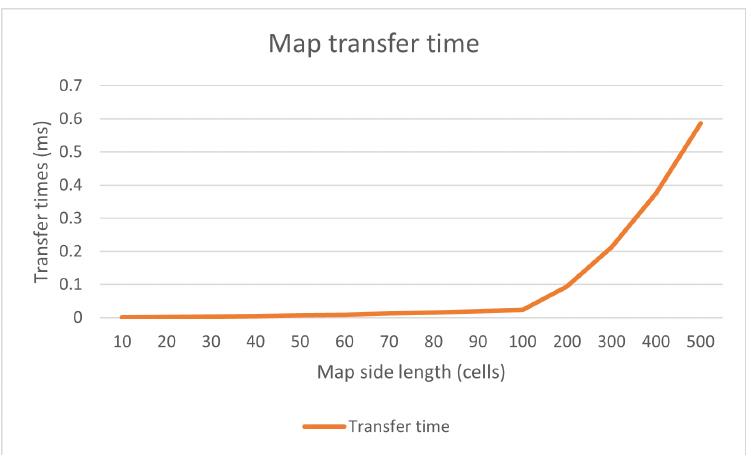
Figure 6. Transfer times of map data. Measurements were made with a connection transmission speed of 1